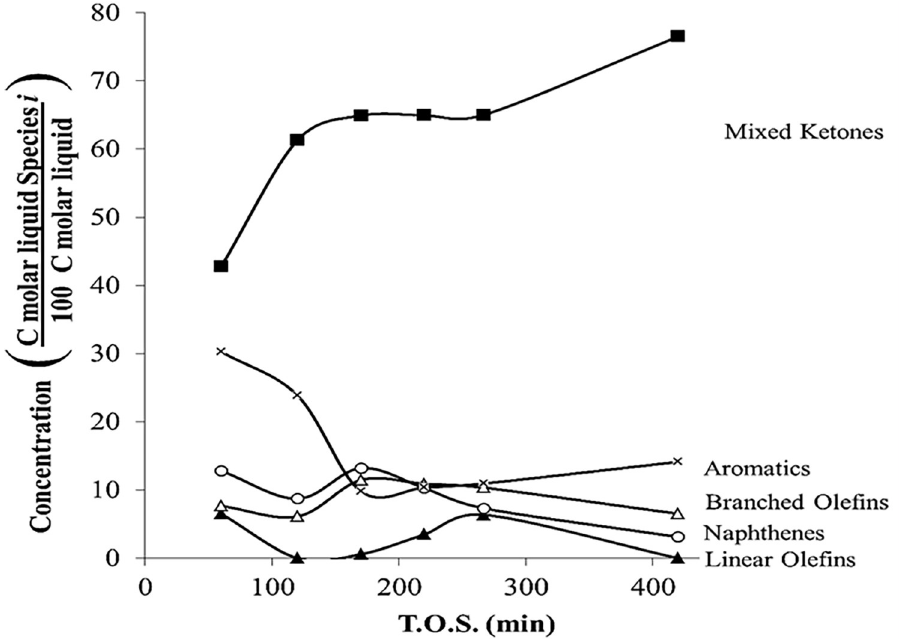
Fig 12. Liquid product distribution for mixed-ketone reaction over HZSM-5(280), WHSV = 1.92 h –1 , T = 510˚C, and P = 101 kPa (abs).